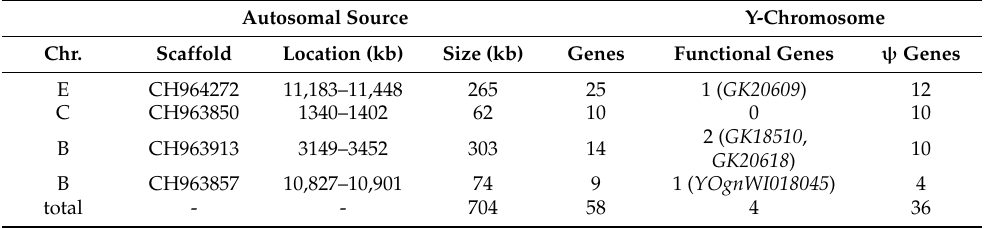
Table 2. Y-linked segmental duplications in D. willistoni